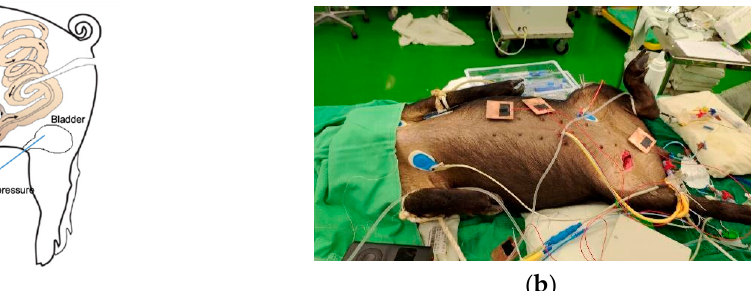
Figure 3. ( a ) Illustration of the pressure detection method used in this swine study. Intraabdominal pressure was created and manipulated by pneumoperitoneum. Then, we inserted one pressure probe into the porcine bladder to measure the intravesical pressure, one probe into the peritoneal cavity to measure the intrabdominal pressure, and a third ingestible pres- sure sensor into the porcine gastrointestinal tract to measure the intraluminal pressure. ( b ) Photograph of the animal study. The pressure detectors settled well into the porcine cavities, and wireless data was collected with external antenna